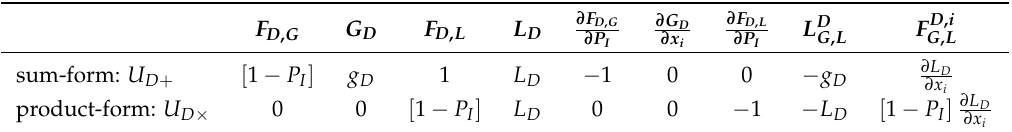
Table 2. Gain and cost terms, their multipliers and other terms for sum-form and product-form utilities of the